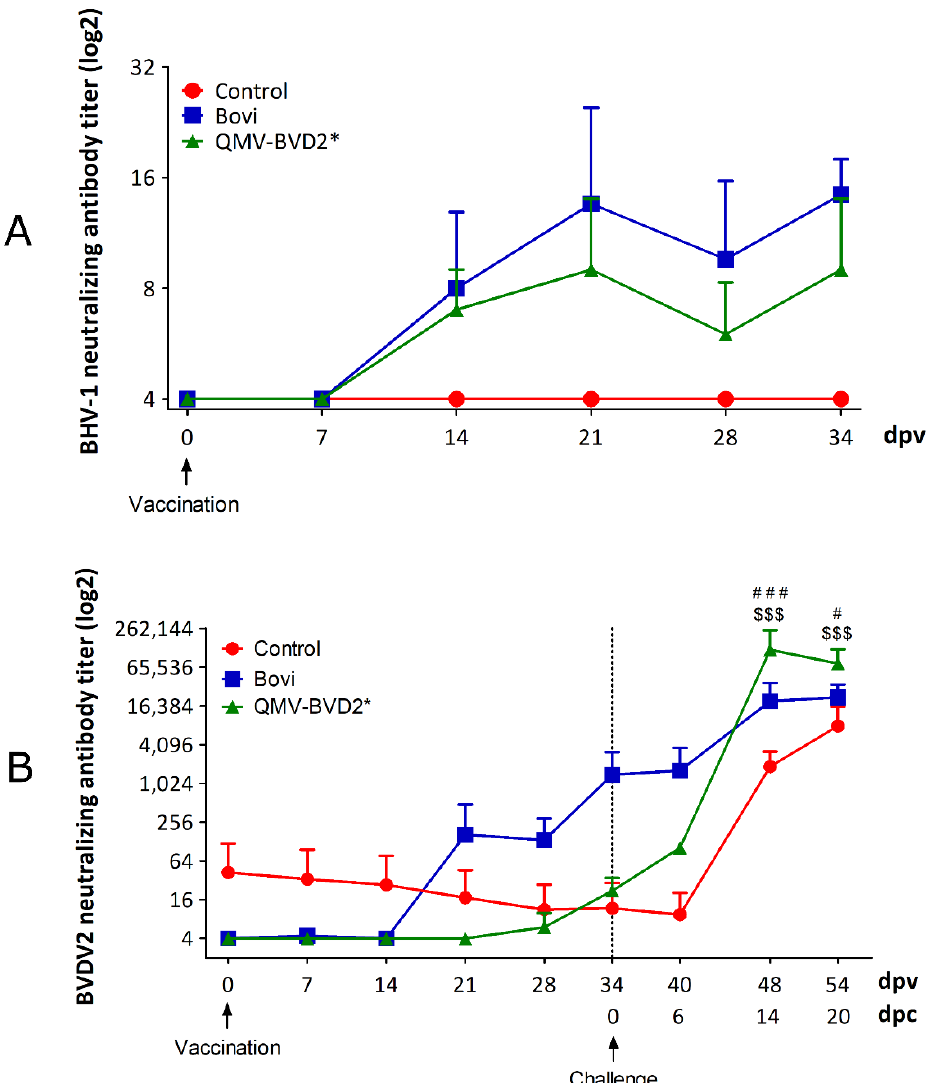
Figure 5. Serum virus neutralizing (SN) antibody titers after vaccination and challenge. SN antibody titers were determined by standard plaque reduction assay. ( A ) BoHV–1–specific SN antibody titer against BoHV–1 Cooper following vaccination. ( B ) BVDV–2–specific SN antibody titer against cp BVDV–2 125. Shown is the mean of each group with SD. Neutralizing titers obtained in each animal are shown in Table S2. The data represent the mean + standard deviation. Significant differences in BVDV–2 neutralizing antibody titer were seen between different groups. Two–way ANOVA followed by Bonferroni post–tests to compare replicate means by row; $$$ p < 0.001 between Control and QMV–BVD2* group. # p < 0.05, ### p < 0.001 between Bovi and QMV–BVD2*